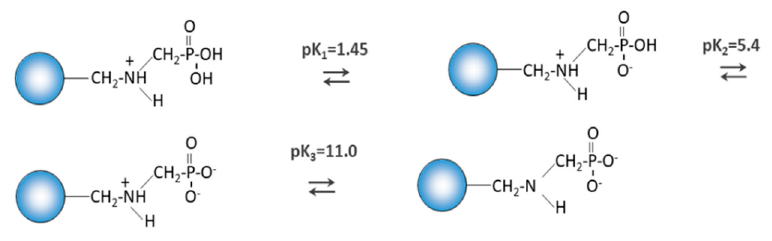
Figure 14. Forms of ion exchangers depending on the pH of the solution.